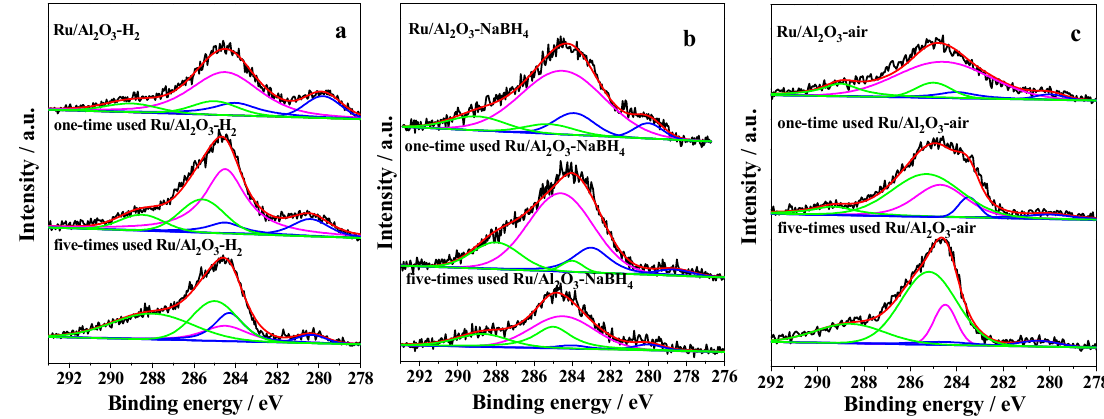
Figure 3. XPS of Ru3d for fresh and used ( a ) Ru/Al 2 O 3 -H 2 ; ( b ) Ru/Al 2 O 3 -NaBH 4 ; ( c ) Ru/Al 2 O 3 -air catalysts (black line: original data line; red line: fitting curve; pink line: the characteristic peak of C; blue line: the characteristic peak of metallic Ru; green line: the characteristic peak of Ru 4+ ).